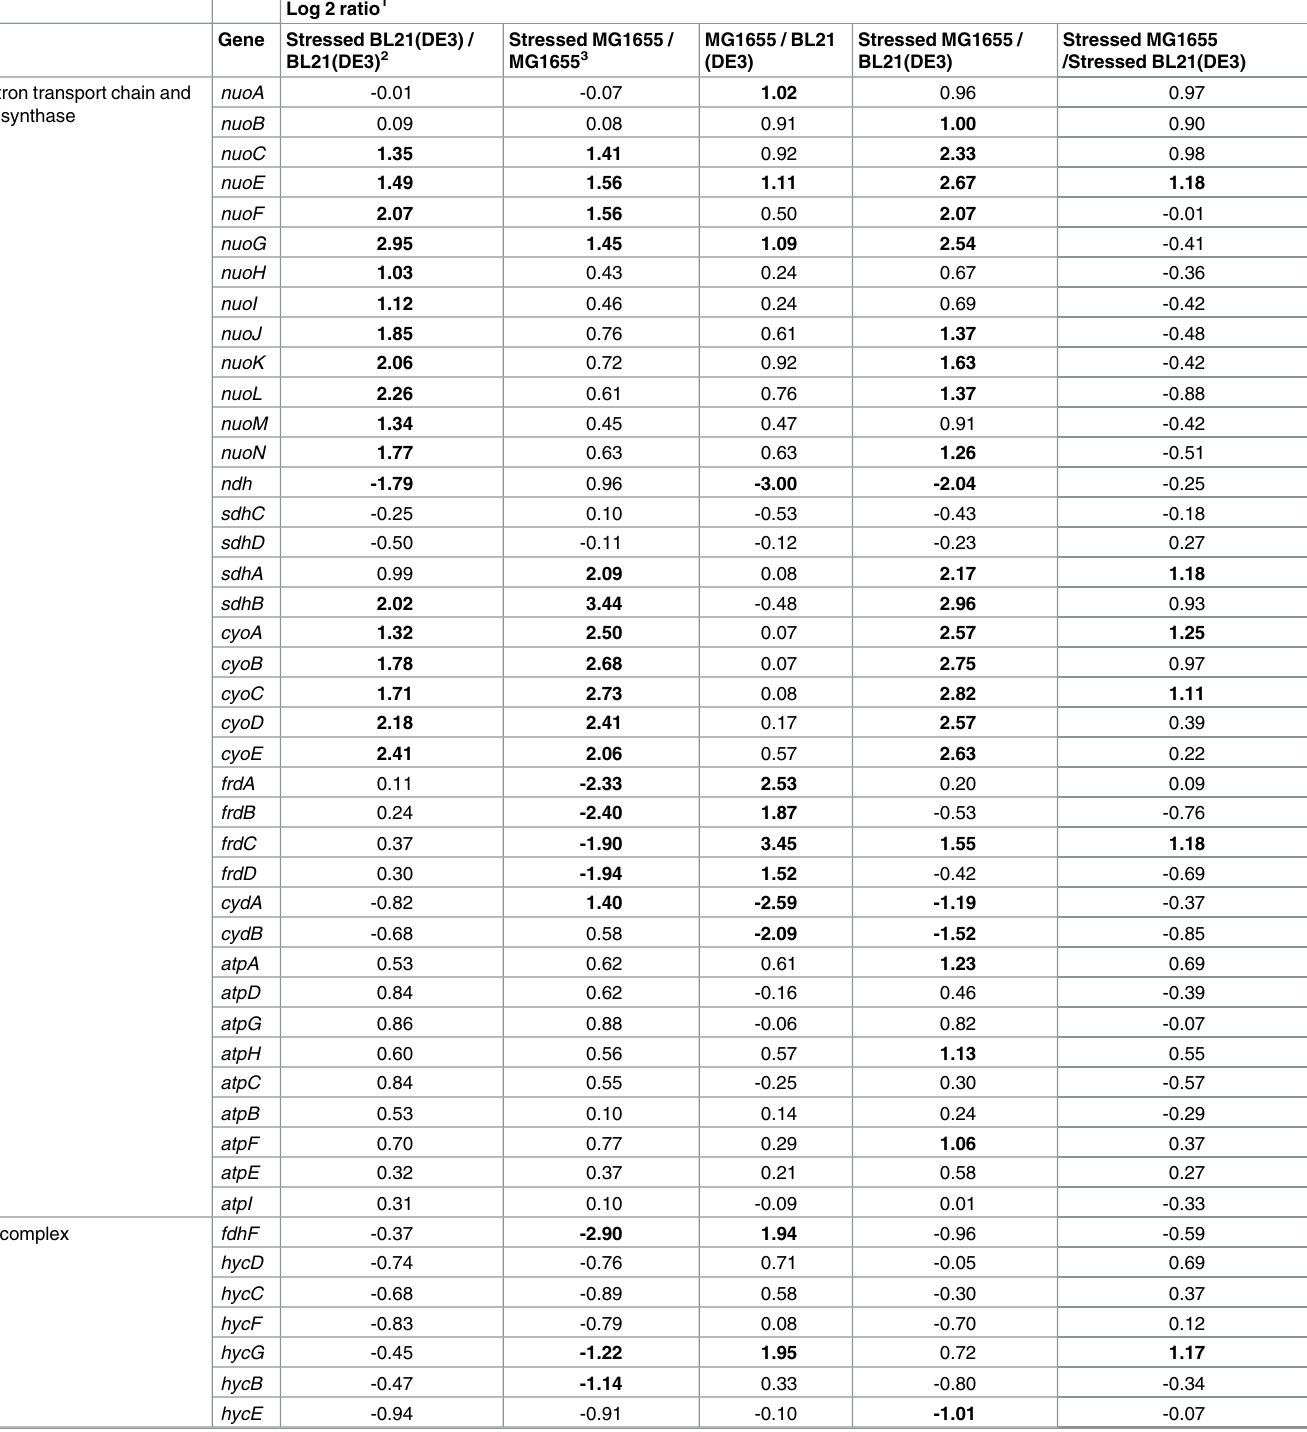
Table 1. Differential gene expression associated with the acid resistance systemsin response to n-heptanoic acid